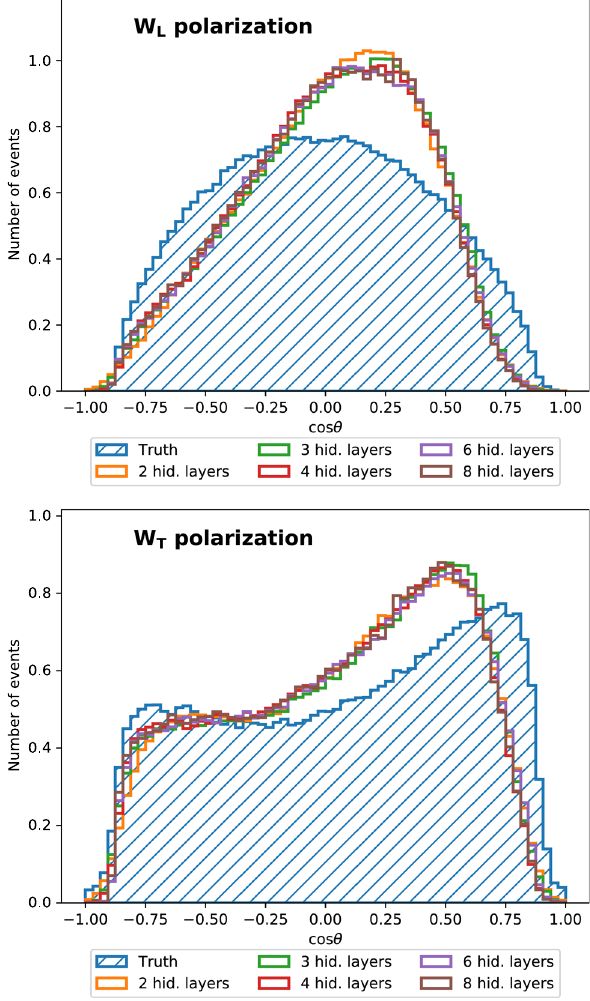
Fig. 12 Angular distribution in the W boson rest frame as a function of cos ϑ , obtained using cos ϑ regression, in the semi-leptonic chan- nel. Parton-level (truth) distributions are shown for comparison, using the generator-level (true) cos ϑ . The top plot shows results obtained assuming the purely longitudinal (W L ) and the bottom plot the purely transverse (W T ) scenario. Results for a DNN with a fixed number of neurons (60) and different hidden-layer configurations are